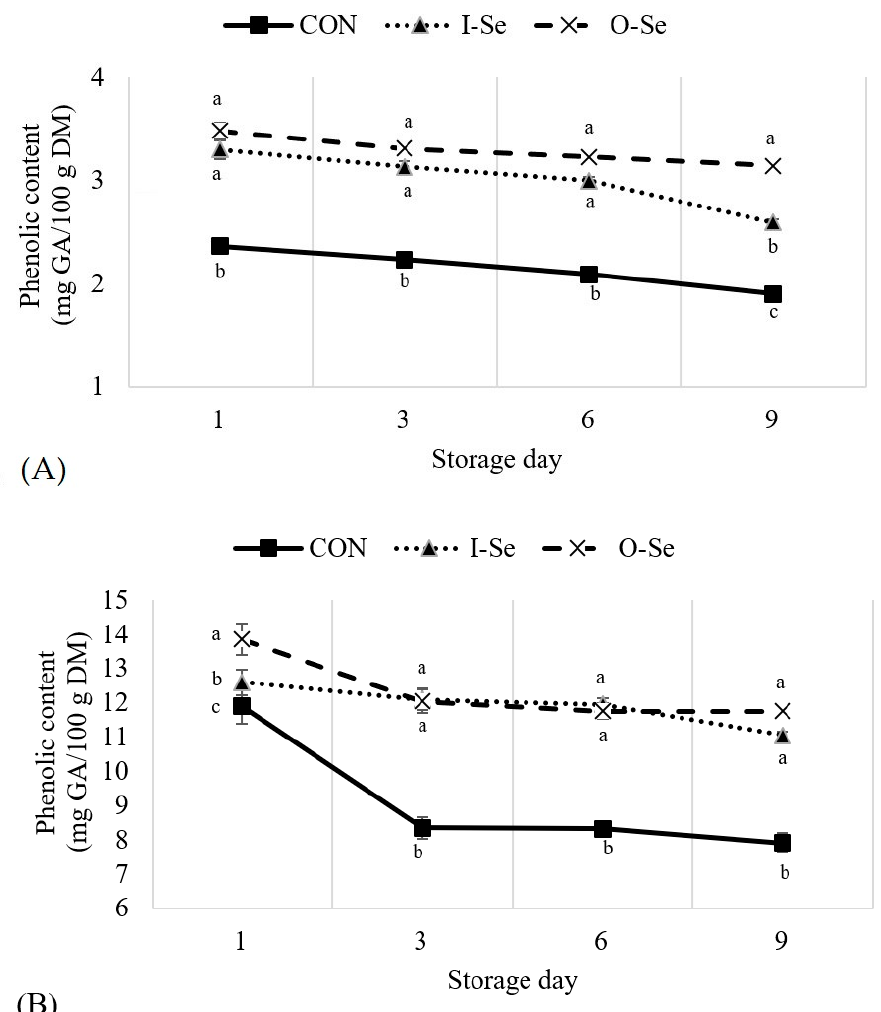
Figure 2. Effects of dietary supplementation with inorganic or organic selenium on the phenolic content for goose meat (equal portions of the breast and thigh meat) ( A ) and liver ( B ) during 9 days of storage at 4 ◦ C. Treatments were defined as CON: basal diet without supplemental selenium; I-Se: basal diet with 0.3 mg/kg inorganic selenium; O-Se: basal diet with 0.3 mg/kg organic selenium. Means within the same day with differing letters are different ( p <